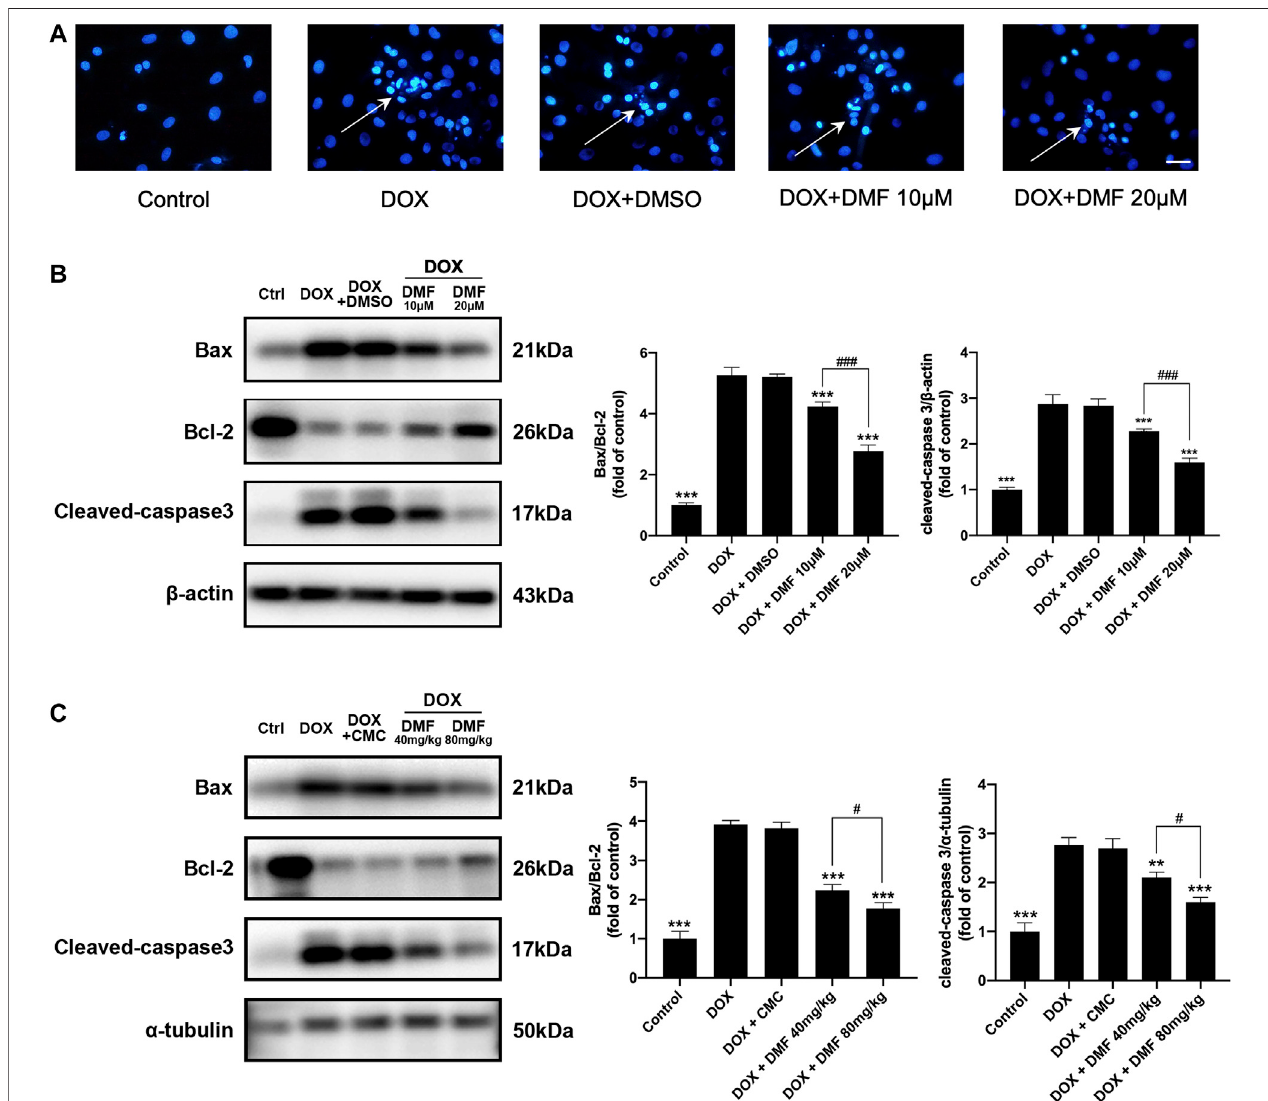
FIGURE4| DMFinhibitedDOX-inducedcardiacapoptosis. (A) Hoechst33258stainingofNRCMsafterDOX(Whitearrowsindicateapoptoticcells, n =5,scalebar = 50 μ m). (B) Representative WB images and quantitative analysis of Bax/Bcl-2 ratio and cleaved caspase-3 in NRCMs ( n = 5). (C) Representative WB images and quantitativeanalysisofBax/Bcl-2ratioandcleavedcaspase-3inrats( n =5).Alldatawereexpressedbymean±SD.** p < 0.01,*** p < 0.001,comparedwithDOXgroup. # p < 0.05, ### p < 0.001 compared with DOX + DMF 40 mg/kg or DOX + DMF 10 μ M.